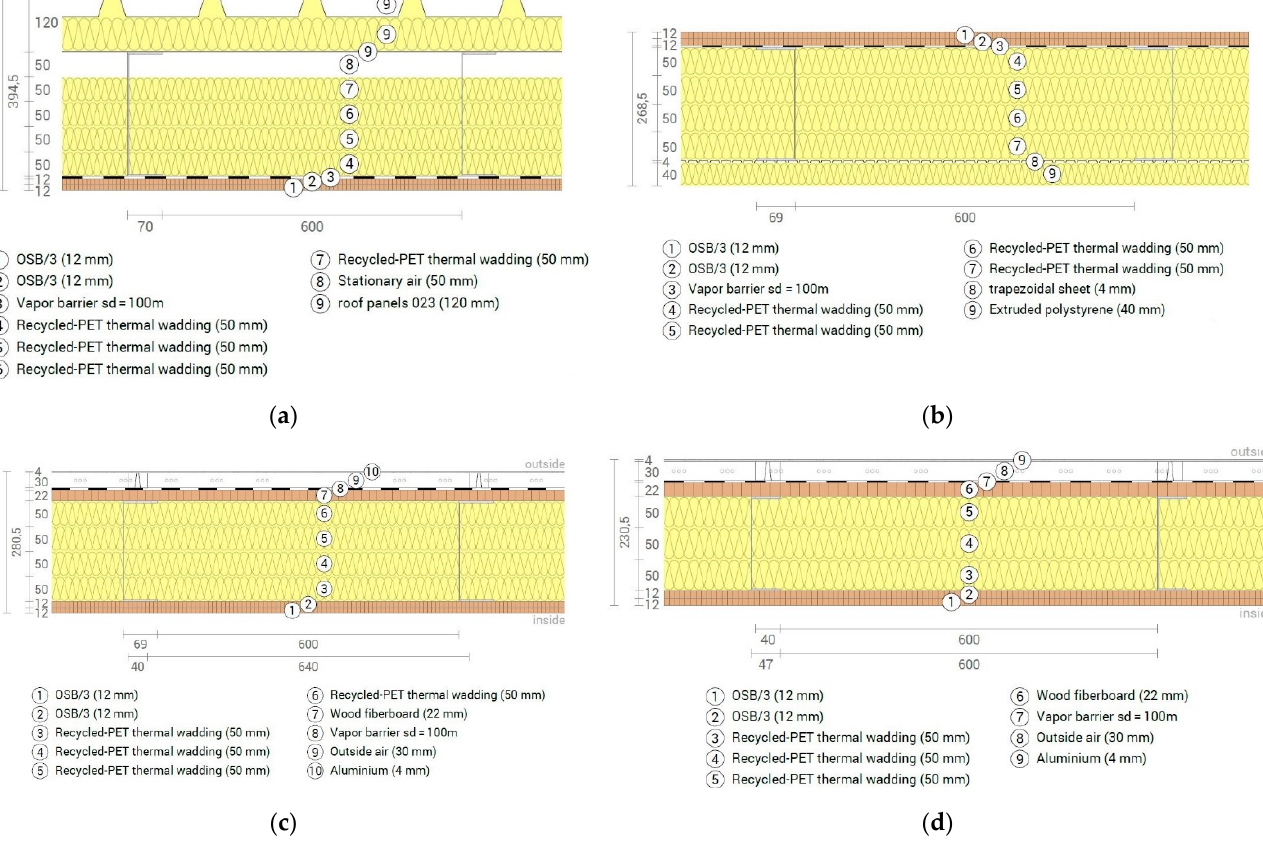
Figure 8. LSF construction elements stratification: ( a ) roof; ( b ) floor; ( c ) northern wall; ( d ) eastern and western wall. As an inner sheathing layer of walls, ceiling, and floor, the LSF experimental module was designed to have oriented strand board (OSB) panels (24 mm thick). In between the steel frame, recycled-PET thermal wadding (150 mm or 200 mm thick, by the case) was used as batt insulation. For walls, the thermal insulation system was completed in the exterior with an overlaid layer of wood fibreboards (22 mm thick) and finished by a layer of rectangular aluminium panels (4 mm thick). In order to avoid moisture from the ground, the floor was 400 mm elevated. In between the steel frame of the floor, recycled PET thermal wadding was used (200 mm thick) as batt insulation. Below the thermal insulation wadding, was installed a layer consisting of trapezoidal steel sheets (4 mm thick), and beneath, an exterior continuous layer (40 mm) of extruded polystyrene (XPS). Both